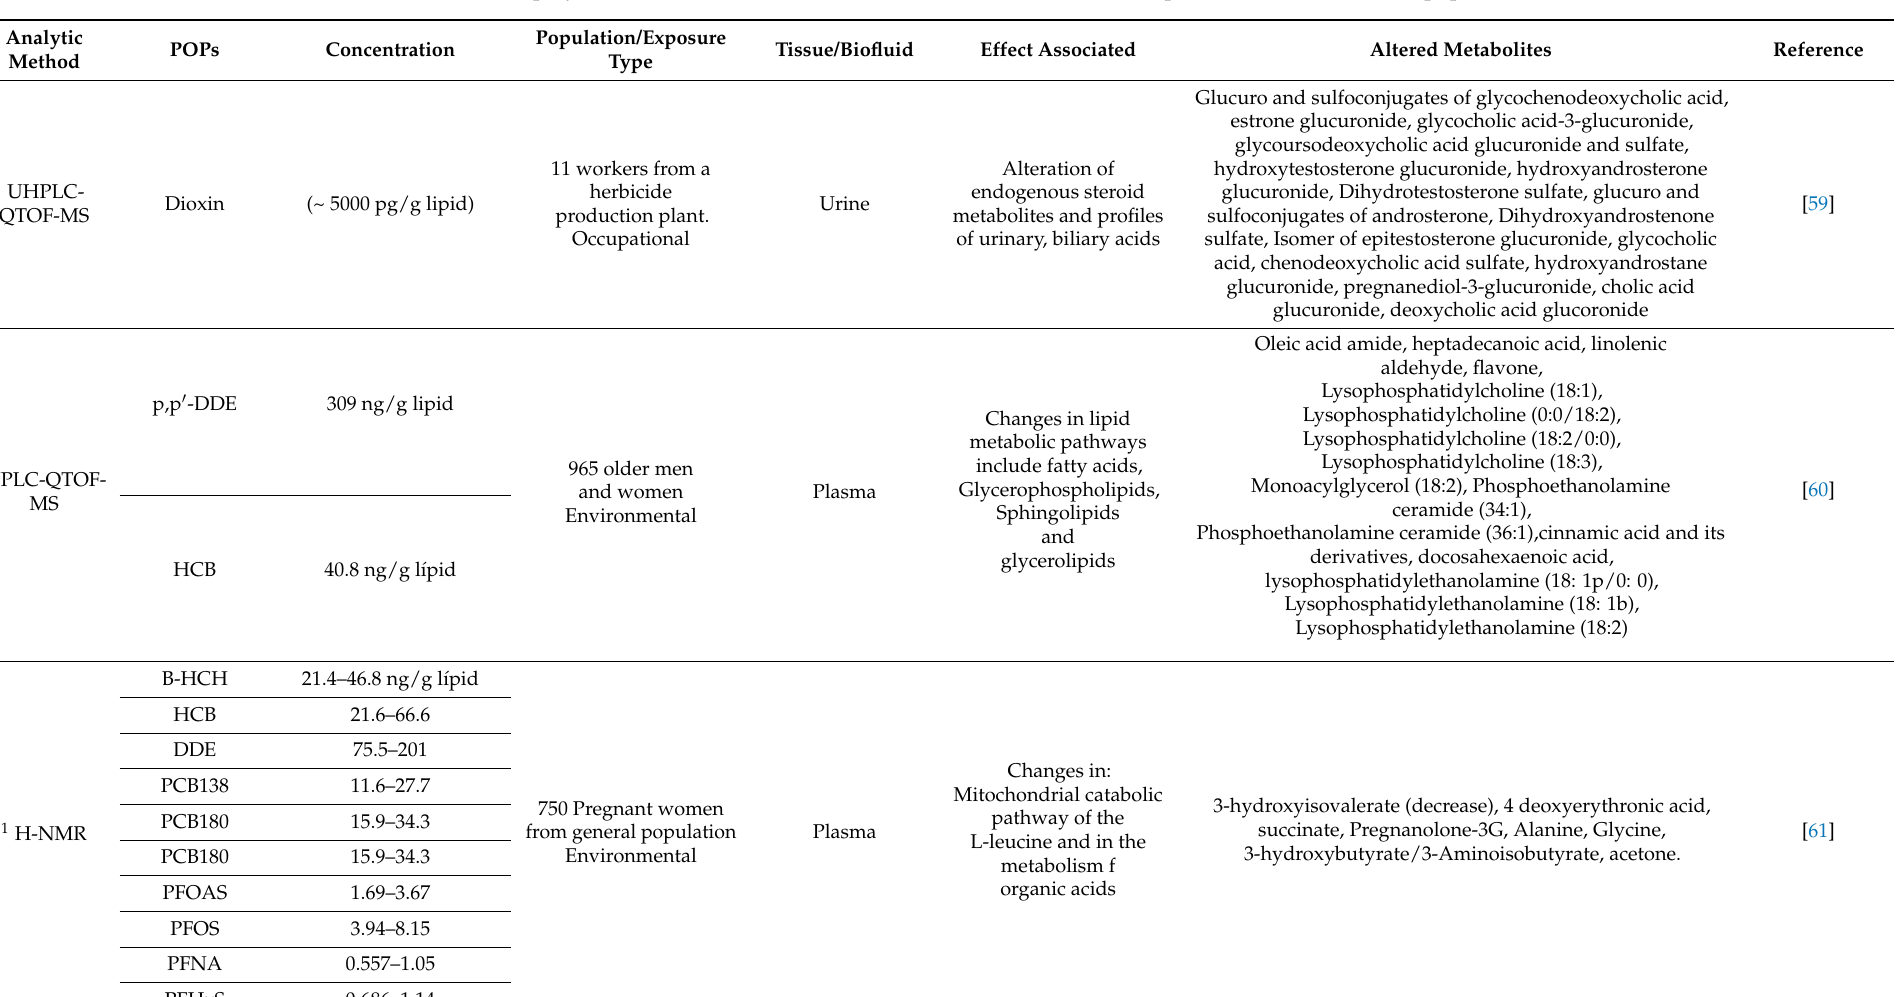
Table 3. Studies that employ metabolomics to evaluate the effects associated with the exposure to POPs in human